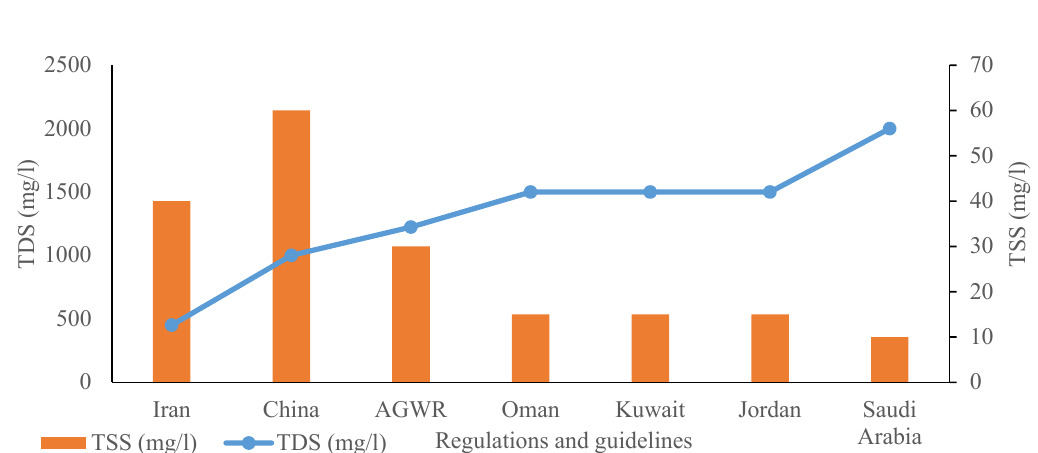
Figure 5. Comparison of the TDS and selected total suspended solids (TSS) thresholds, required in agricultural water reuse regulations and guidelines which included both of TDS and TSS thresholds.